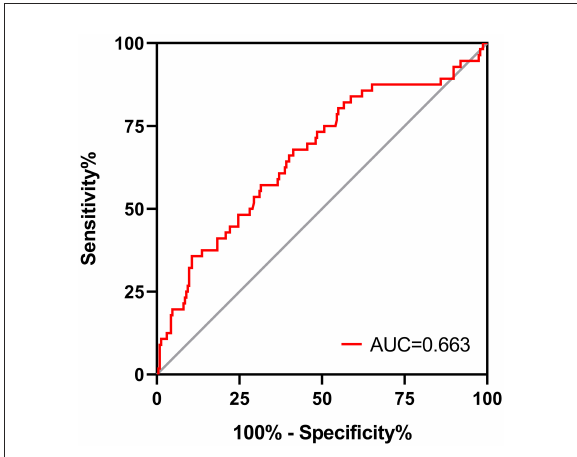
FIGURE5 ROC curve for dialysate IL-6 AR to predict UF insufficiency in PD patients. AR, appearance rate; UF, ultrafiltration.